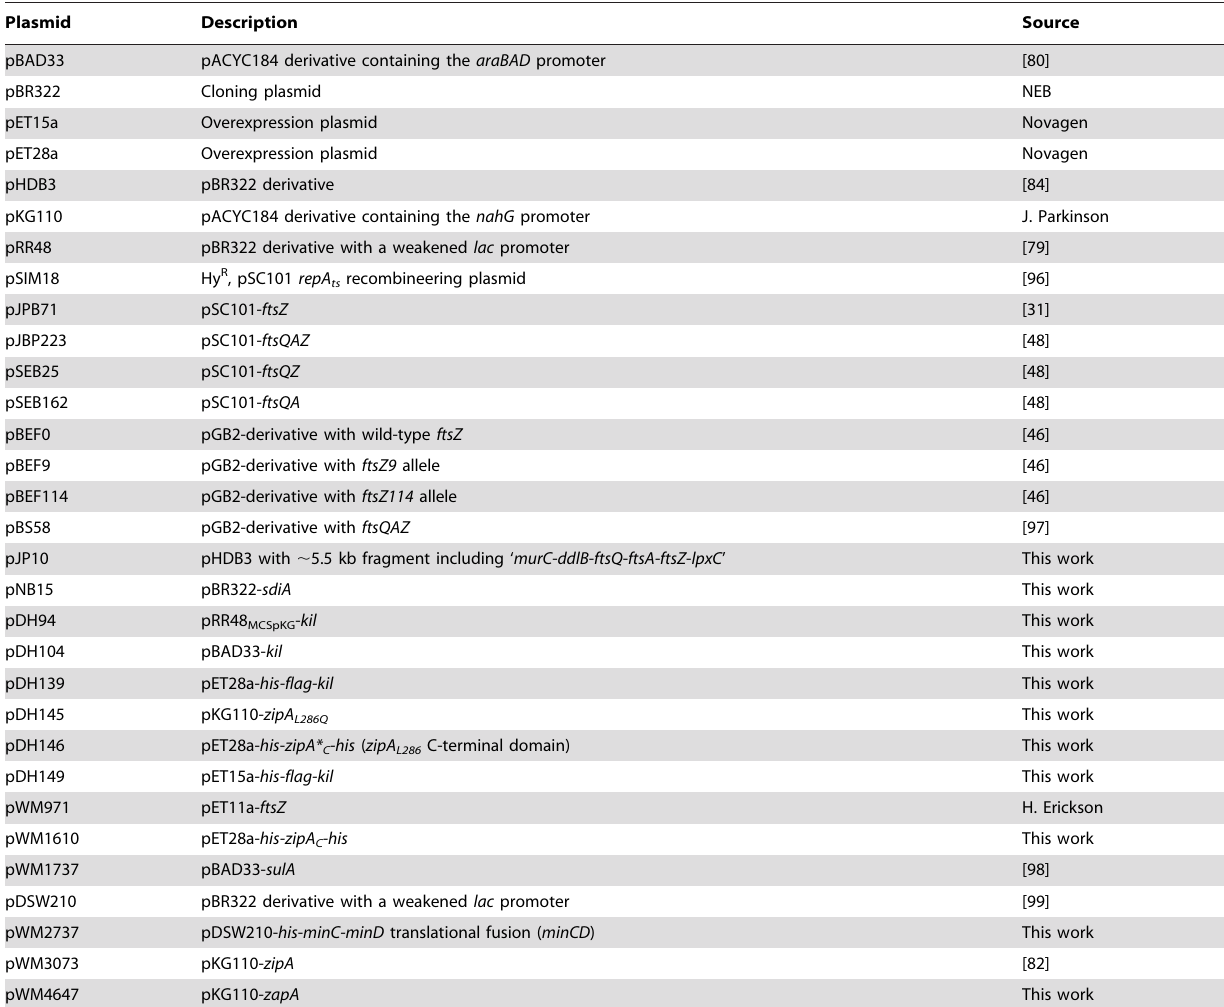
Table 2. Plasmids used in this study.